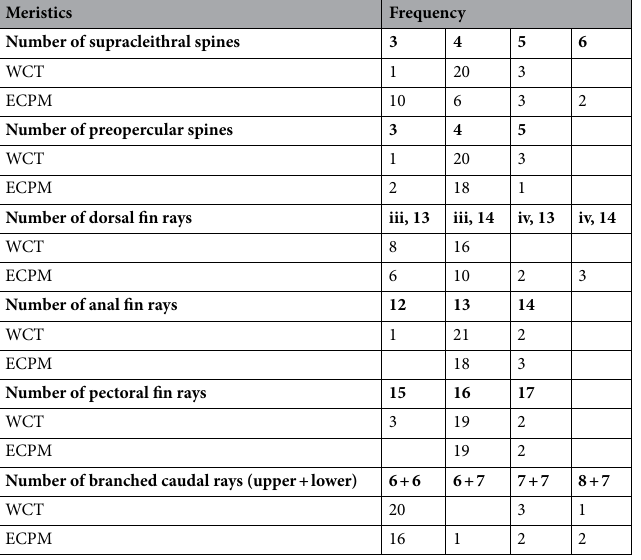
Table 3. Selected meristics characters of Uranoscopus cognatus from the west coast Thailand (WCT) and east coast Peninsular Malaysia